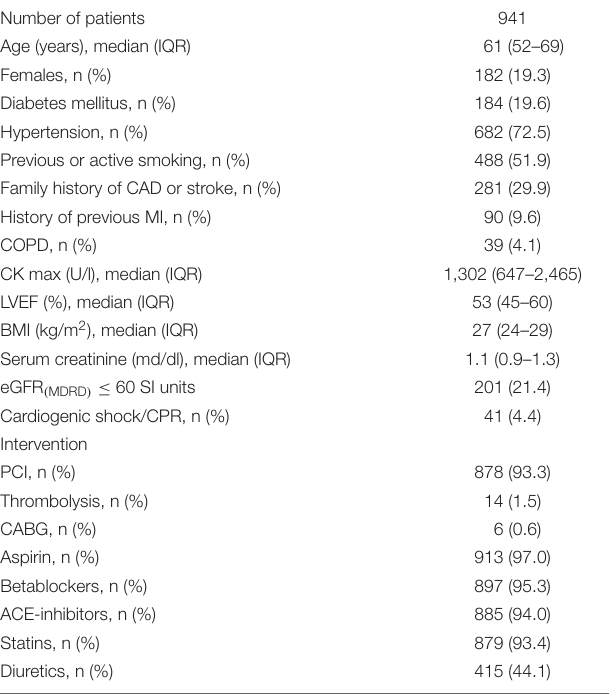
TABLE 1 | Clinical characteristics of the study population. Number of